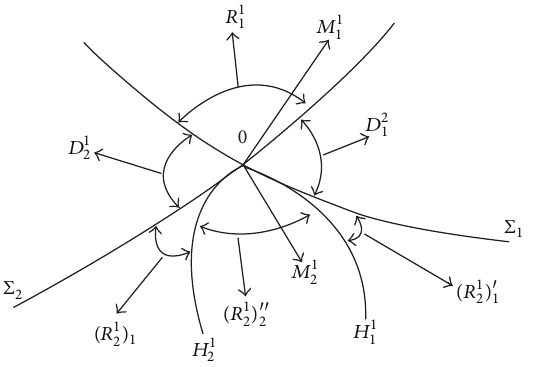
Figure 5: Bifurcation diagram in case Δ 1 = Δ 2 = −1 , 0 < 𝛼 ≪ 1 , −1 ≪ 𝛼 ln |𝑀 1